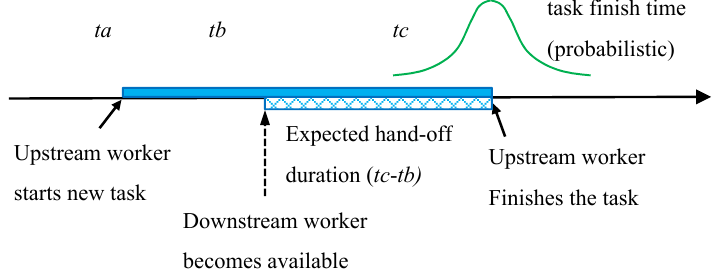
Figure 2. Hand-o ff loss in BB-based assembly cell. The expected hand-o ff time is tc − tb Figure 2. Hand-off loss in BB-based assembly cell. The expected hand-off time is tc-tb .